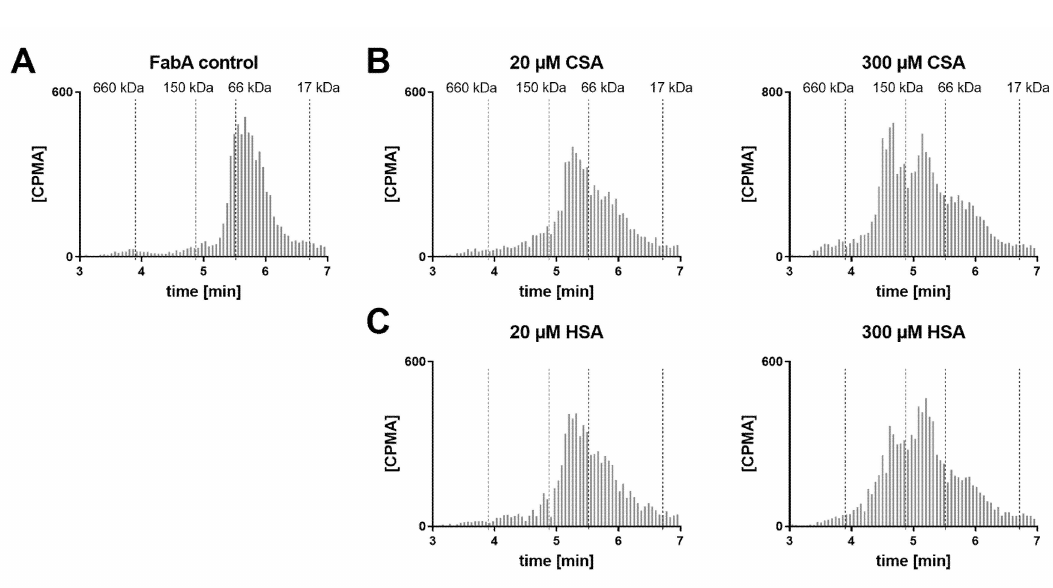
Figure 4. Radio-size exclusion chromatograms of dosing formulations with ( A ) FabA alone and increasing concentrations of ( B ) CSA or ( C )